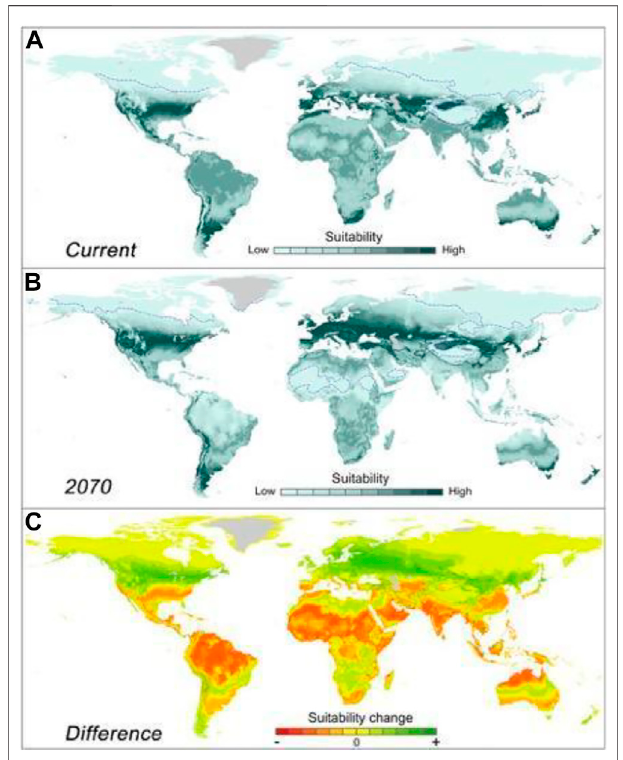
FIGURE3| Projectedgeographicalshiftinthehumantemperatureniche in terms of the suitability for human habitation. Large areas of the earth will have signi fi cantly lower suitability in terms of temperature, especially in the tropics and subtropics. Top panel. Current position of the human temperature niche. Mid panel. Change projected for 2070 with RCP8.5. Bottom panel. Bottom panel. Differences between the two maps. (Xu et al., 2020. Reprinted by